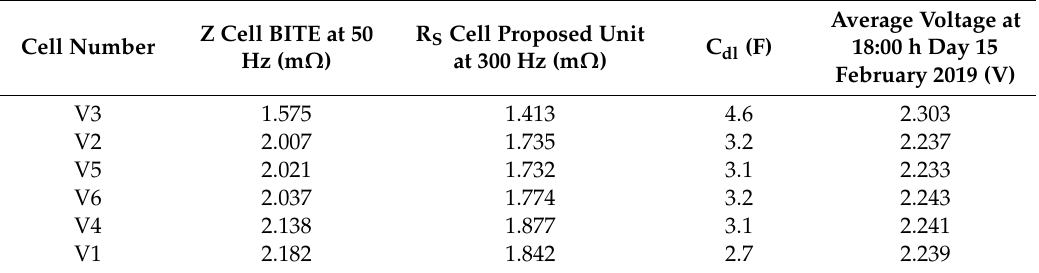
Table 2. Double layer